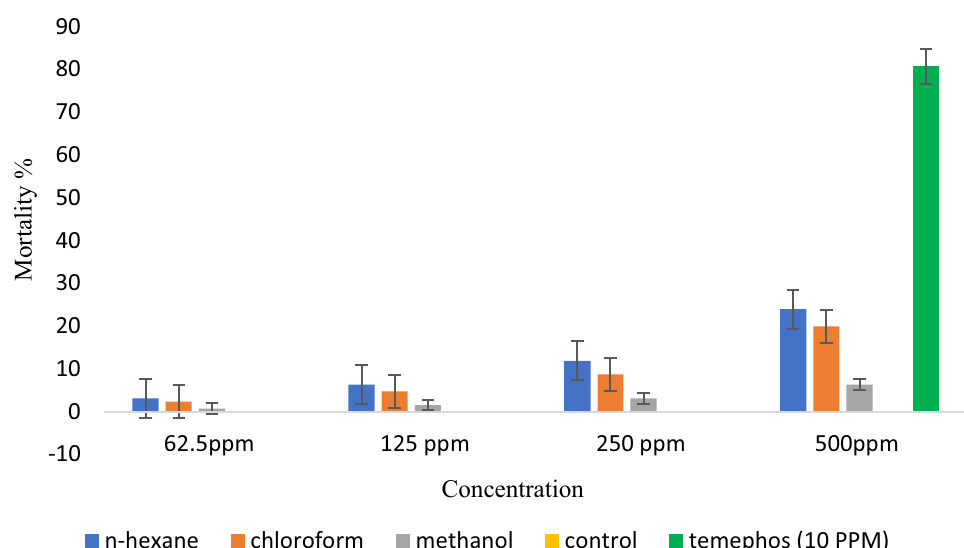
Fig. 2 Percentage ovicidal activity of crude extracts of leaves of P. pterocarpum against Cx. quinquefasciatus